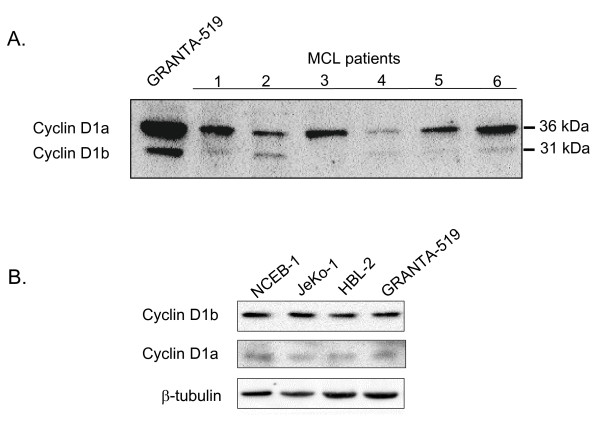
Cyclin D1a and cyclin D1b protein expression. A. Whole cell extracts were obtained from CD19+ cells of MCL patients, separated on SDS-PAGE and sequentially immunoblotted with anti-cyclin D1a (sc-718) or anti-cyclin D1b (R3) Abs. For loading controls, blots were also revealed with anti-β-tubulin Ab (sc-9104, not shown). B. Proteins were obtained from MCL cell lines and analyzed as described in A except that we used DCS-6 anti-cyclin D1 Ab which recognizes both isoforms.